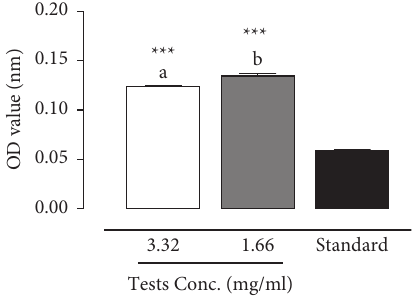
Figure 2: Antioxidant activity of polysaccharides extract of T. le-testui as measured by the TBA method at 532 nm and compared to standards (vitamin C). Table 2: Effect of T. le-testui crude polysaccharides on phagocytosis and energy metabolism in methylprednisolone-treated rats. Treatments Dosage Phagocytic index